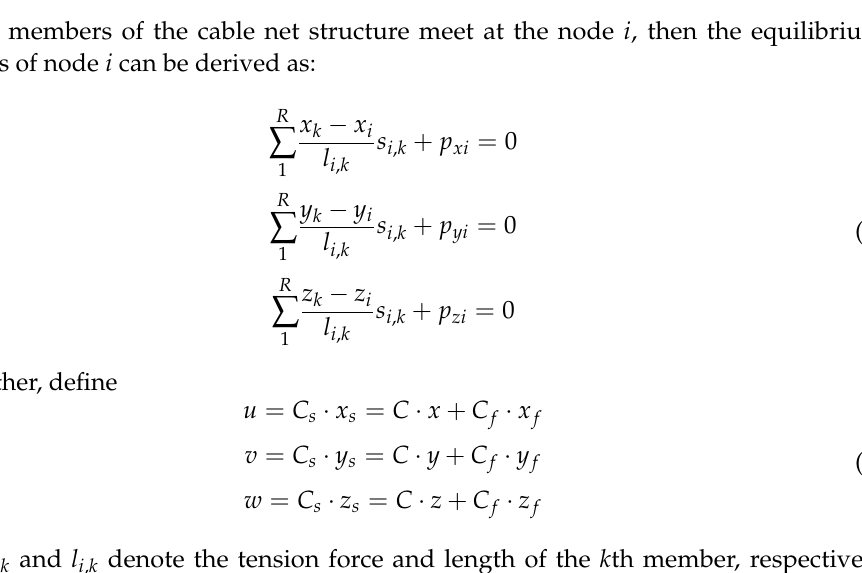
Figure 4. A two-dimensional cable